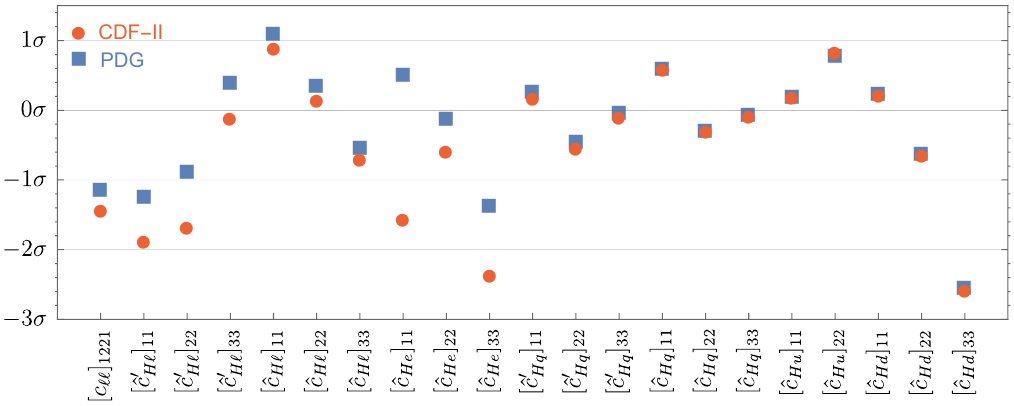
Figure 3 . Pulls of the flavorful fit results using the CDF-II measurement of the W mass (red dots) and PDG average (blue